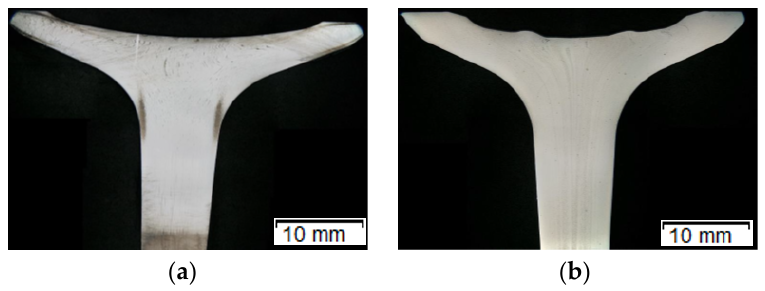
Figure 1. Photo with a macro-analysis of the fibre orientation in valves produced by way of: ( a ) upsetting and forging, ( b ) hot extrusion and forging [12].